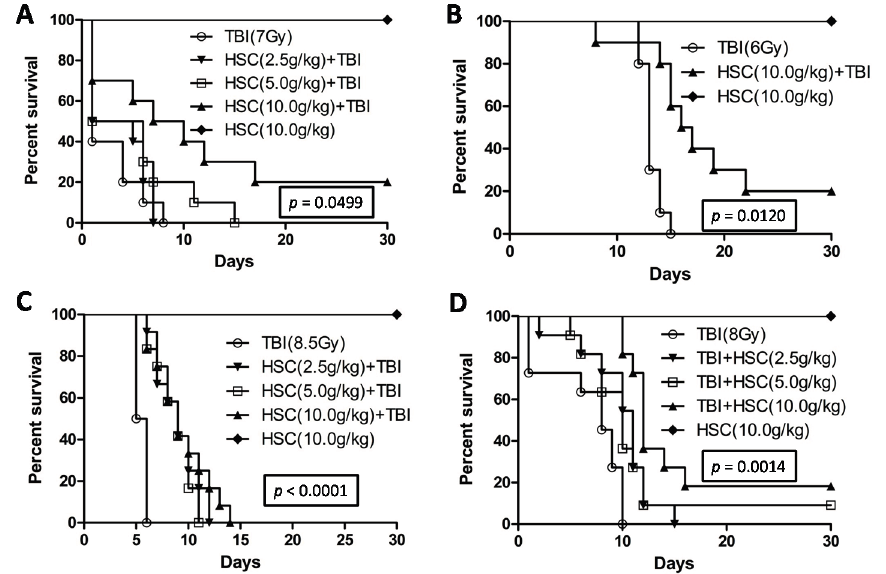
Figure 1. Comparison of survival curves by using the Kaplan–Meier method. ( A ) 30-day survival of rats ( n = 10 per group) pretreated with HSC (2.5, 5, and 10 g/kg) before exposure to 7 Gy TBI. The survival curves were significantly different as predicted by the log rank test. ( p = 0.0499); ( B ) 30-day survival of rats ( n = 10 per group) pretreated with HSC (10 g/kg) before exposure to 6 Gy TBI. The survival curves were significantly different as predicted by the log rank test. ( p = 0.0120); ( C ) 30-day survival of mice ( n = 12 per group) pretreated with HSC (2.5, 5 and 10 g/kg) before exposure to 8.5 Gy TBI. The survival curves were significantly different as predicted by the log rank test. ( p < 0.0001); and ( D ) 30-day survival of mice ( n = 11 per group) treated with HSC (2.5, 5 and 10 g/kg) after exposure to 8 Gy TBI. The survival curves were significantly different as predicted by the log rank test. ( p =